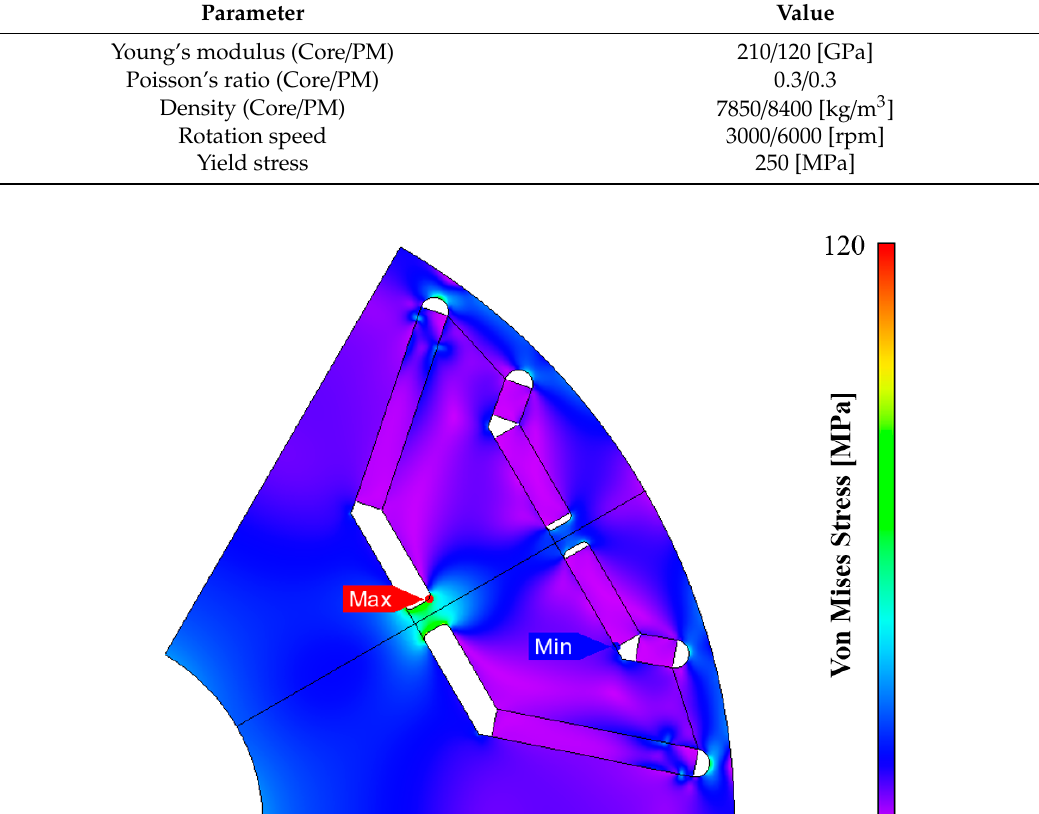
Figure 13. Von Mises stress analysis result of the optimum model.